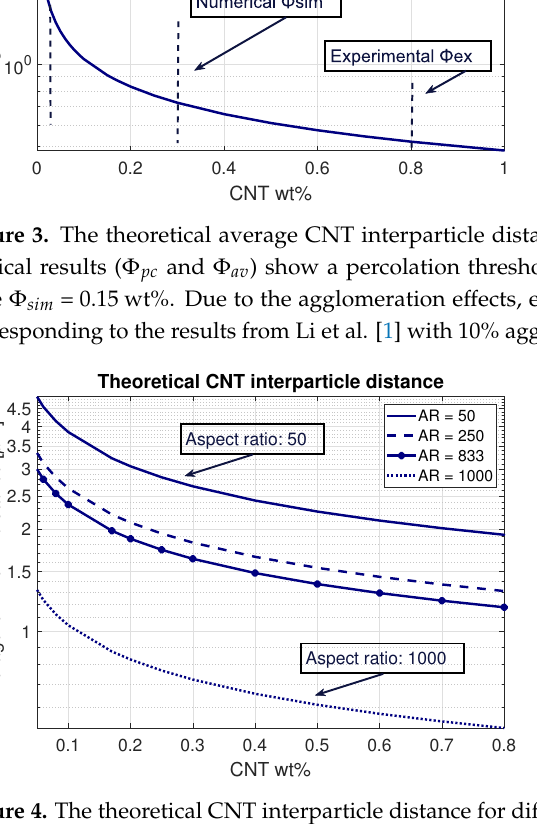
Figure 4. The theoretical CNT interparticle distance for different multi-walled carbon nanotubes in relation with the weight percentage in the polymer. The aspect ratio (AR) influences the percolation threshold due to the large change in CNT interparticle